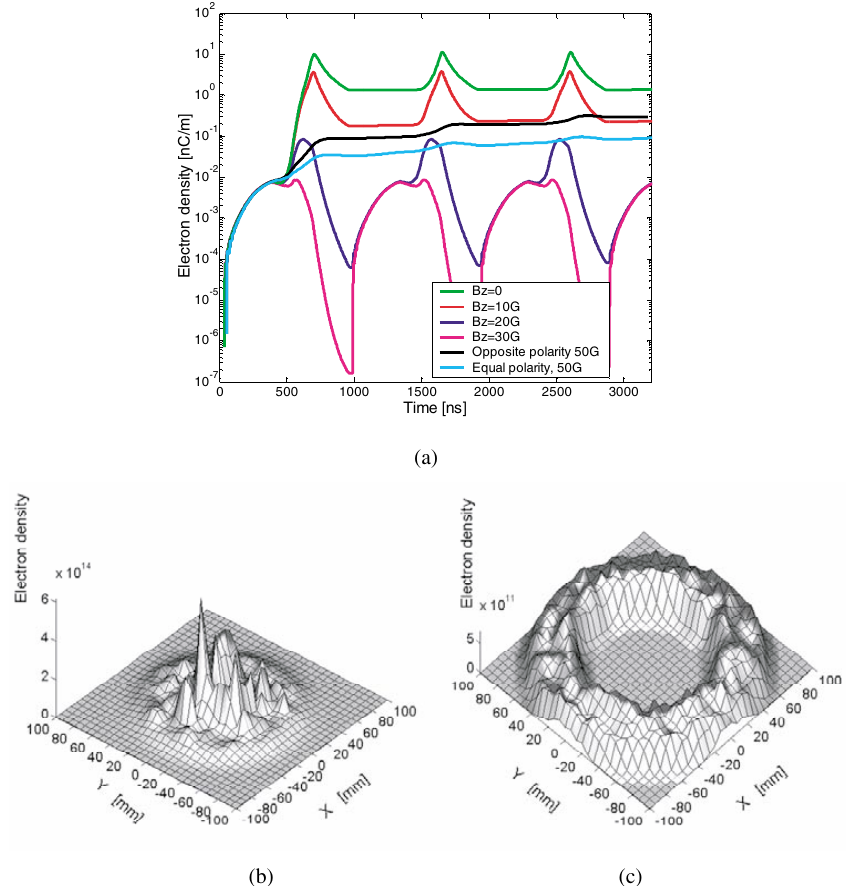
FIG. 14. (Color) Effects of solenoid’s configuration on the buildup and distribution of the electron cloud. (a) Electron cloud’s buildup, (b) its distribution with opposite polarity configuration, and (c) its distribution with equal polarity